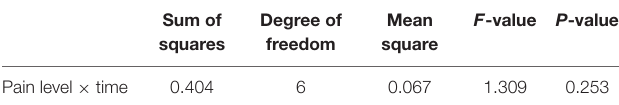
TABLE 8 | Interaction between pain level and